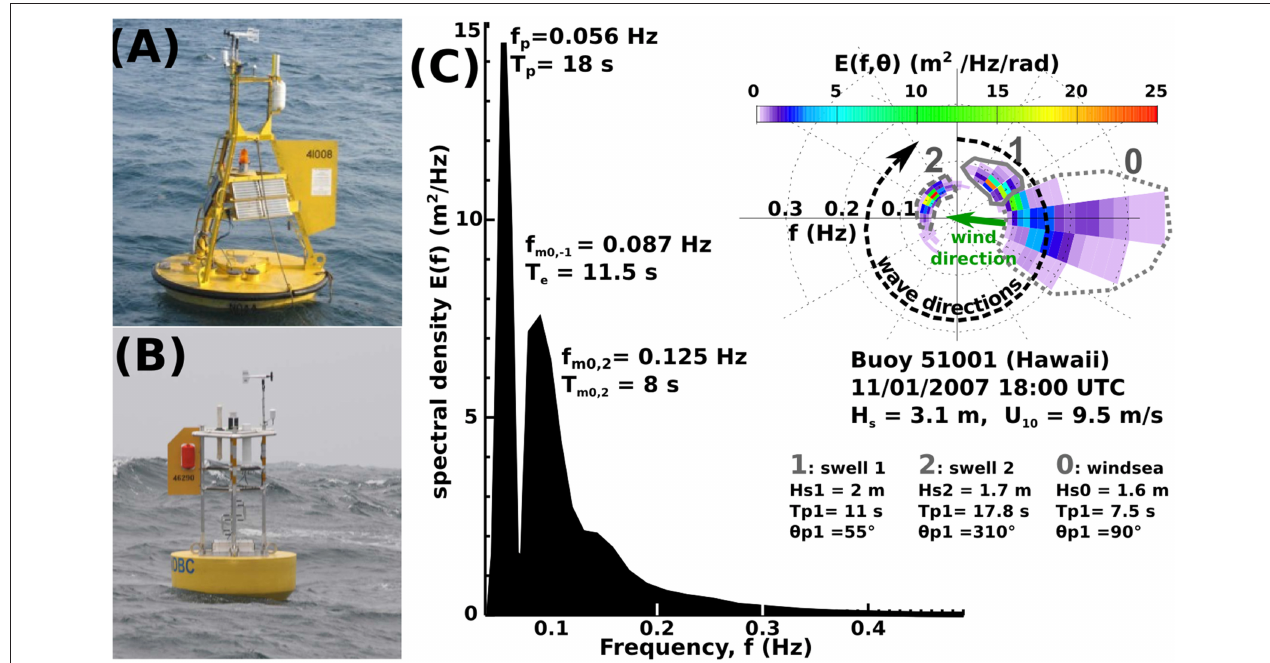
FIGURE 1 | (A,B) show typical layout of NBDC wave buoys with old and new designs. Wave measurements are made by a motion package in the hull and wind measurements use an anemometer at 5-m height. (C) Example of wave information derived from a buoy, ranging form the common estimate of H s to the heave spectrum E ( f ) in black, or a two-dimensional directional spectrum E ( f , θ ) in colors. Note that the buoy does not measure the directional spectrum but, for each frequency, only the “First 5” parameters from which the directional spectrum is estimated here using the Maximum Entropy Method (Lygre and Krogstad, 1986). For many applications it is customary to partition the spectrum into a windsea region (dotted contour labeled 0), and swells (solid and dashed contours labeled 1 and 2) which are usually ordered by decreasing wave energy. For each partition, height, period and direction parameters are estimated in the same manner as they would be estimated from a full (frequency-direction)